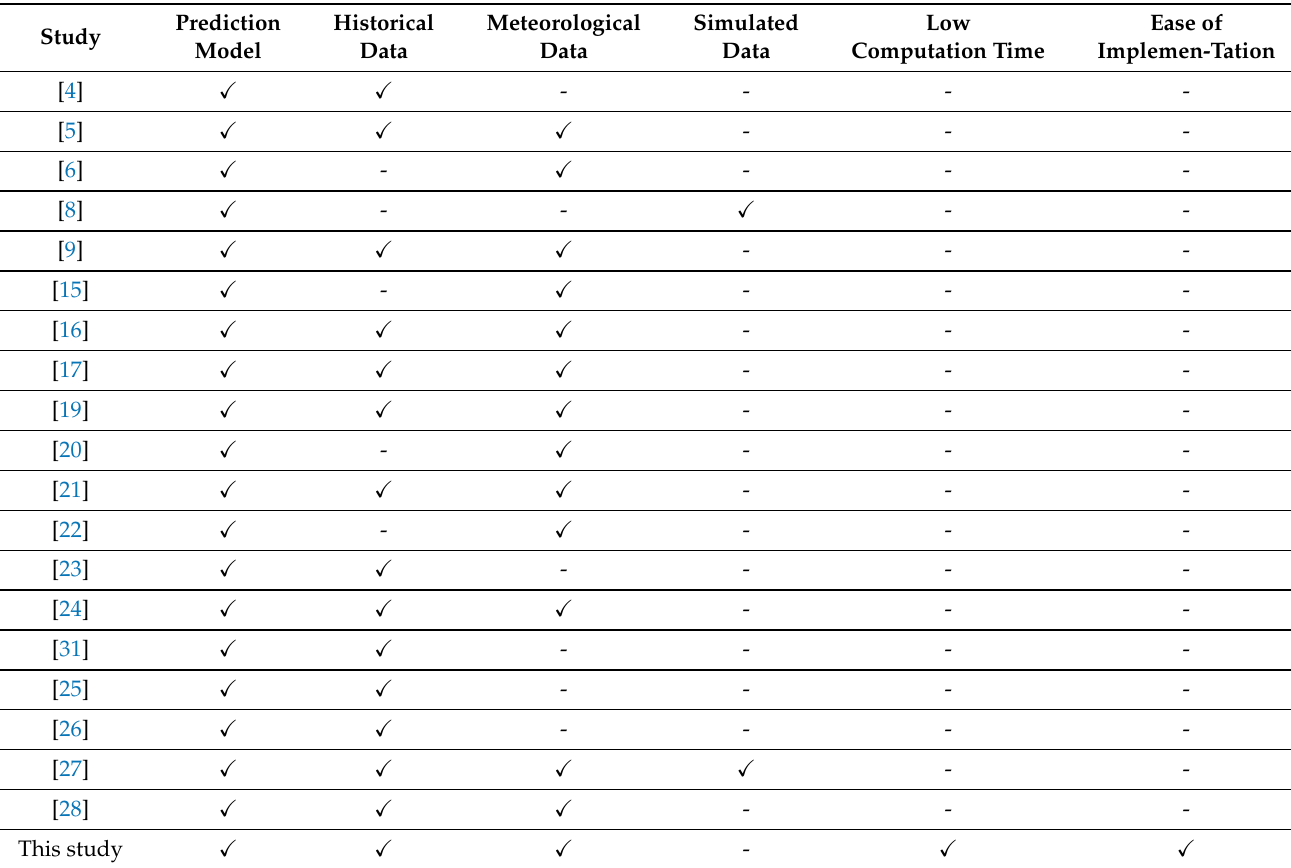
Table 1. Comparison of